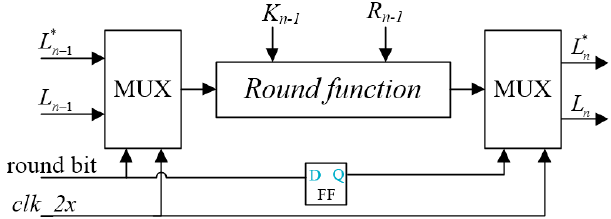
Figure 11. Block diagram of SIMON round circuit by double rate technology.